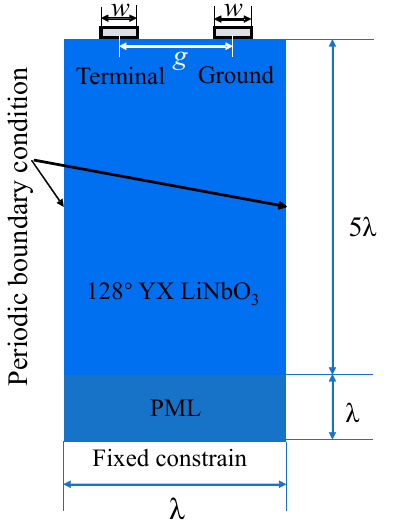
Figure 2. FEM model of an IDT unit cell with boundary conditions.